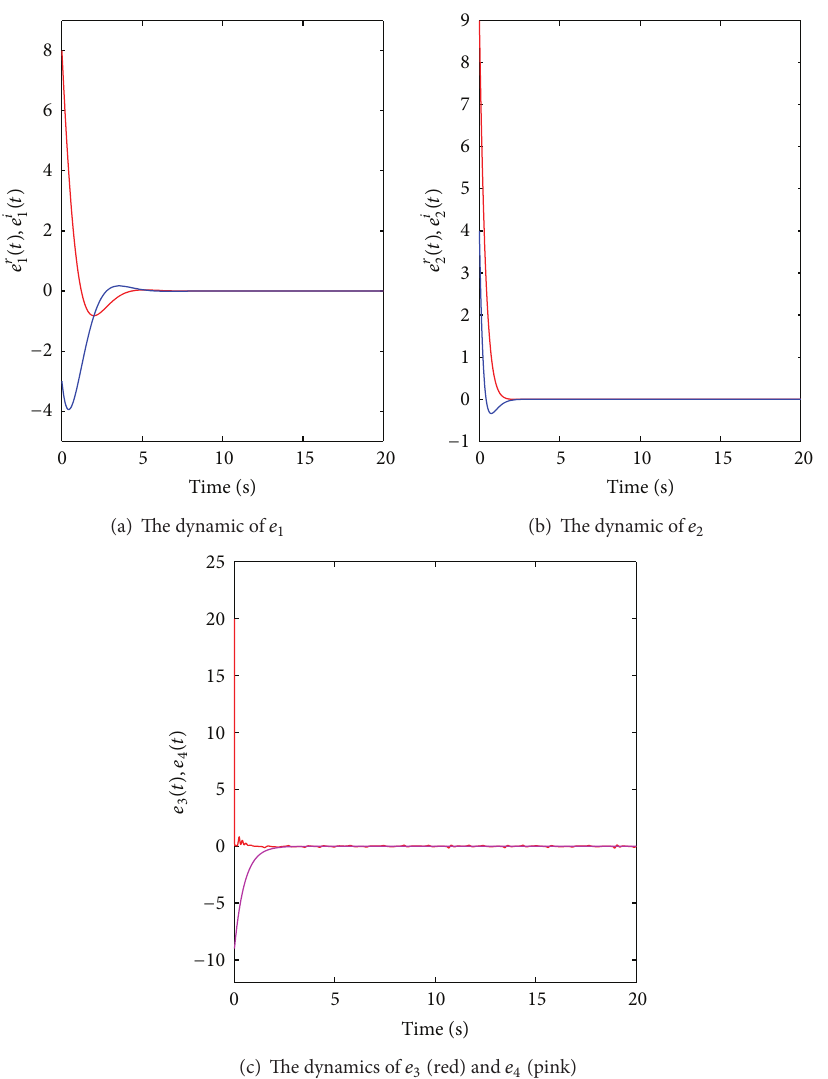
Figure 9: CMHPS error dynamics between 3-dimensional complex chaotic L¨u drive system (37) and 4-dimensional complex hyperchaotic Dadras response system